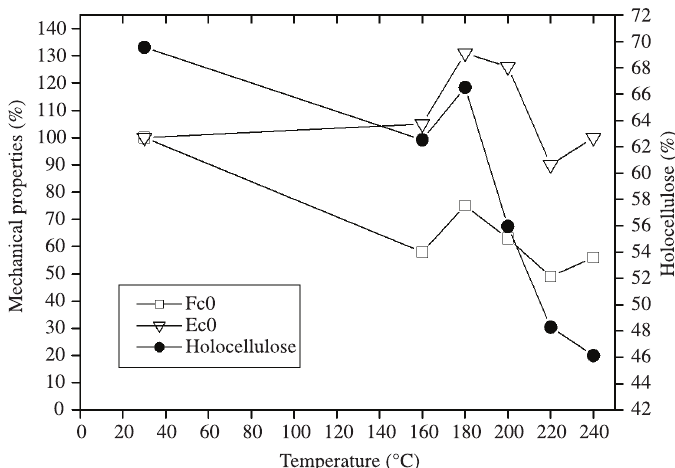
Figure 2. Mechanical properties and holocellulose content in function of